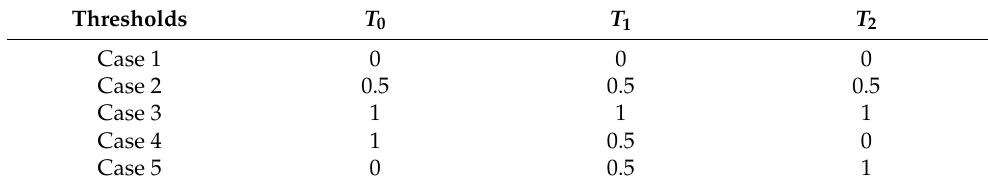
Table 6. Different initial thresholds.